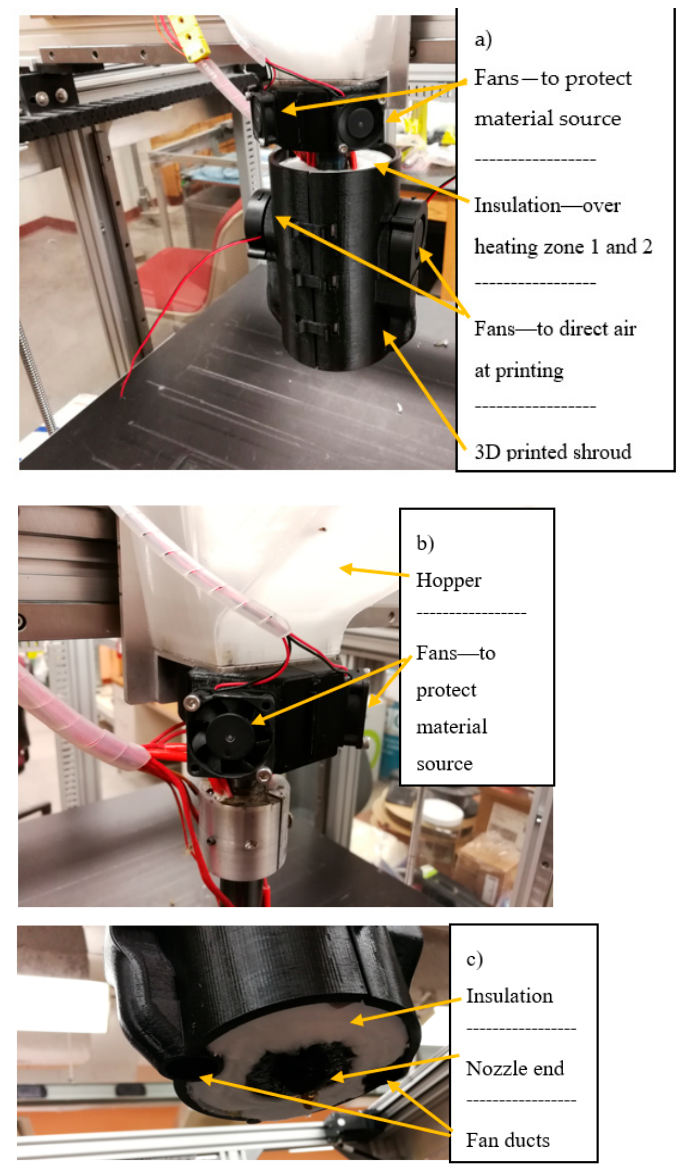
Figure 1. Gigabot X prototype additional cooling system showing ( a ) installation, ( b ) fan attachment at hopper, and ( c ) nozzle end.